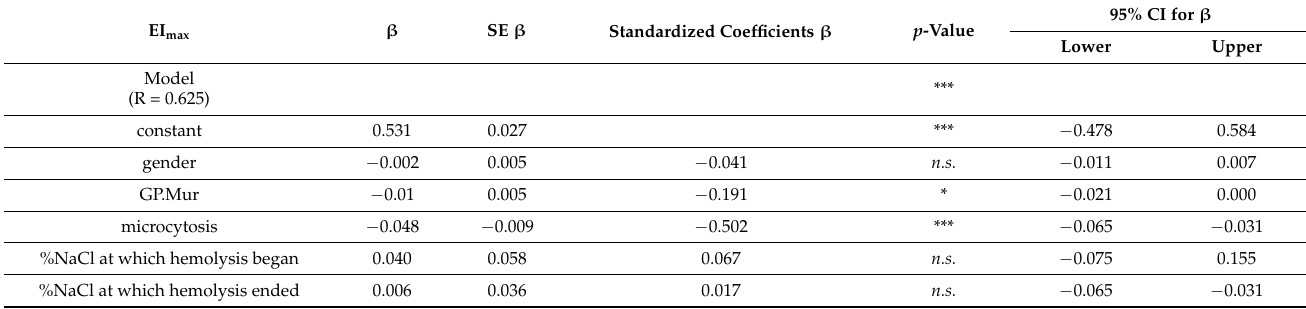
Table 3. In this multivariate regression analysis for EI max , gender, GP.Mur phenotype, microcytosis, and %NaCl at which hemolysis began and ended were the independent variables. R , or the multiple correlation coefficient for this model, was 0.625, suggesting a good level of prediction of EI max using these independent variables. β is the unstandardized coefficient which indicates the magnitude of the effect of an independent variable when other independent variables are controlled. Standardized β suggests the relative contribution of all the independent variables in this regression model. The p -value indicates whether an independent variable indeed contributes significantly to the model for EI max ; *** p < 0.001; * p < 0.05; n.s ., not significant. This model showed that (1) EI max (the main indicator for RBC deformability) was independent from osmotic fragility and (2) RBC deformability was significantly influenced by individual GP.Mur phenotype and microcytosis/hypochromia.